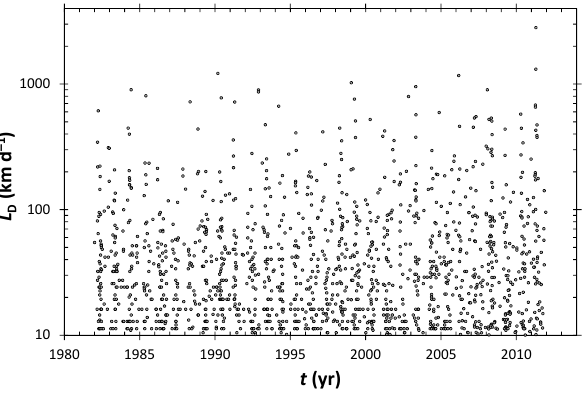
Fig. 12. Cumulative number of continental USA severe tornado out- breaks per year N c with daily total path lengths greater than or equal to L D , given as a function of L D . Data are given for six 10-yr pe- riods from 1952–2011. Outbreak path lengths L D are based only on tornadoes with path lengths L ≥ 10km (defined in this paper to be severe tornadoes). Tornado path length data L are from NOAA